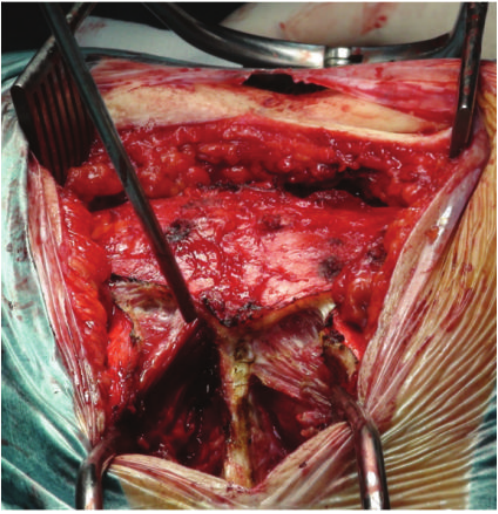
Figure 7: Superior subperiosteal